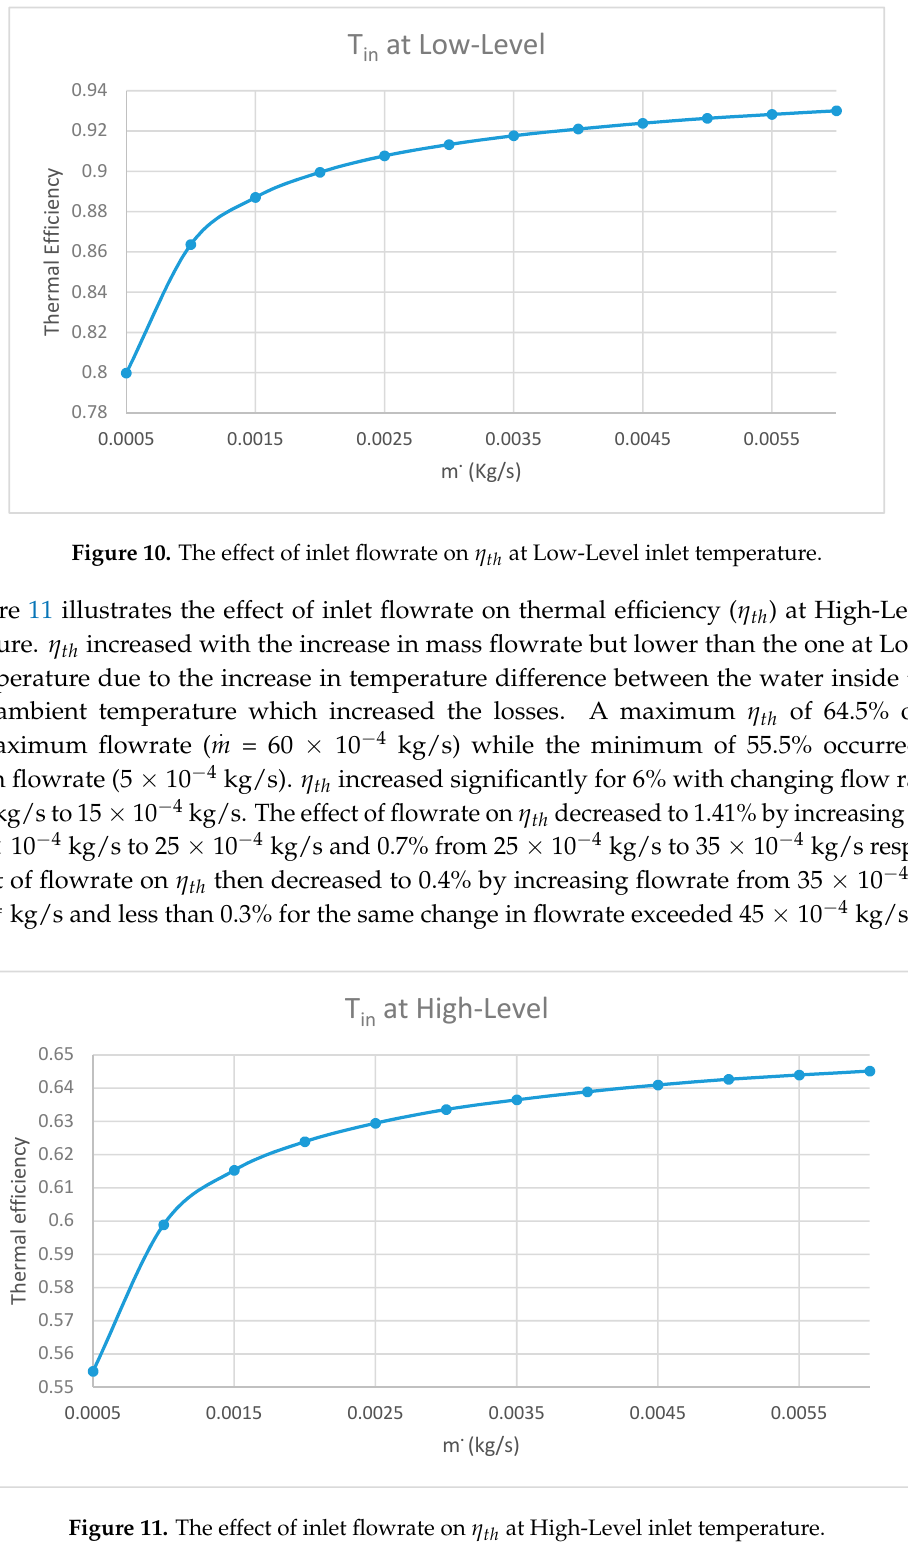
th at High-Level inlet